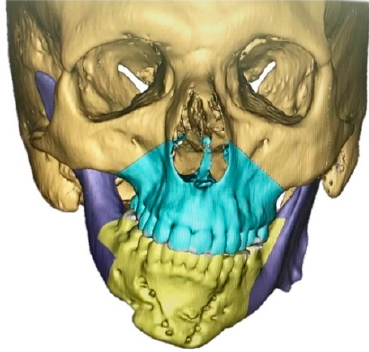
Figure 1. Preoperative virtual planning. Baseline situation as identified by CBCT. Color-coded: maxilla (turquoise), corpus mandibulae (yellow), and rami mandibulae (purple).